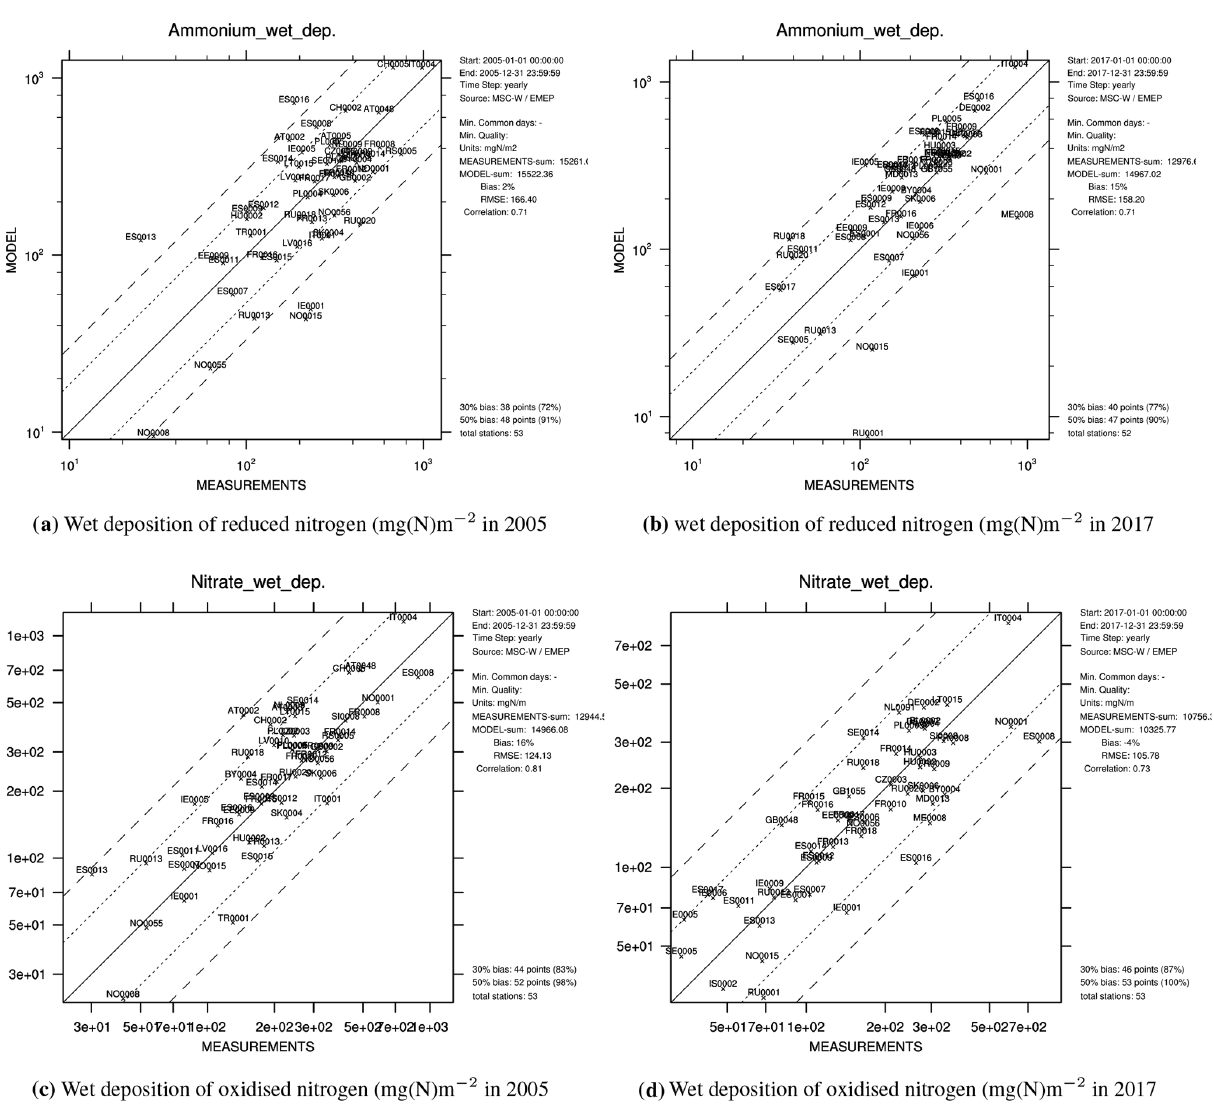
Figure A3. Scatter plots of modelled versus observed wet depositions of reduced nitrogen (a, b) and oxidised nitrogen (c, d) for the years 2005 (a, c) and 2017 (b, d) . Statistics with a limited set of common measurement sites are given in Table A1. Site positions are listed in Table A2. Measurements were downloaded from http://ebas.nilu.no (last access: 14 December 2021).